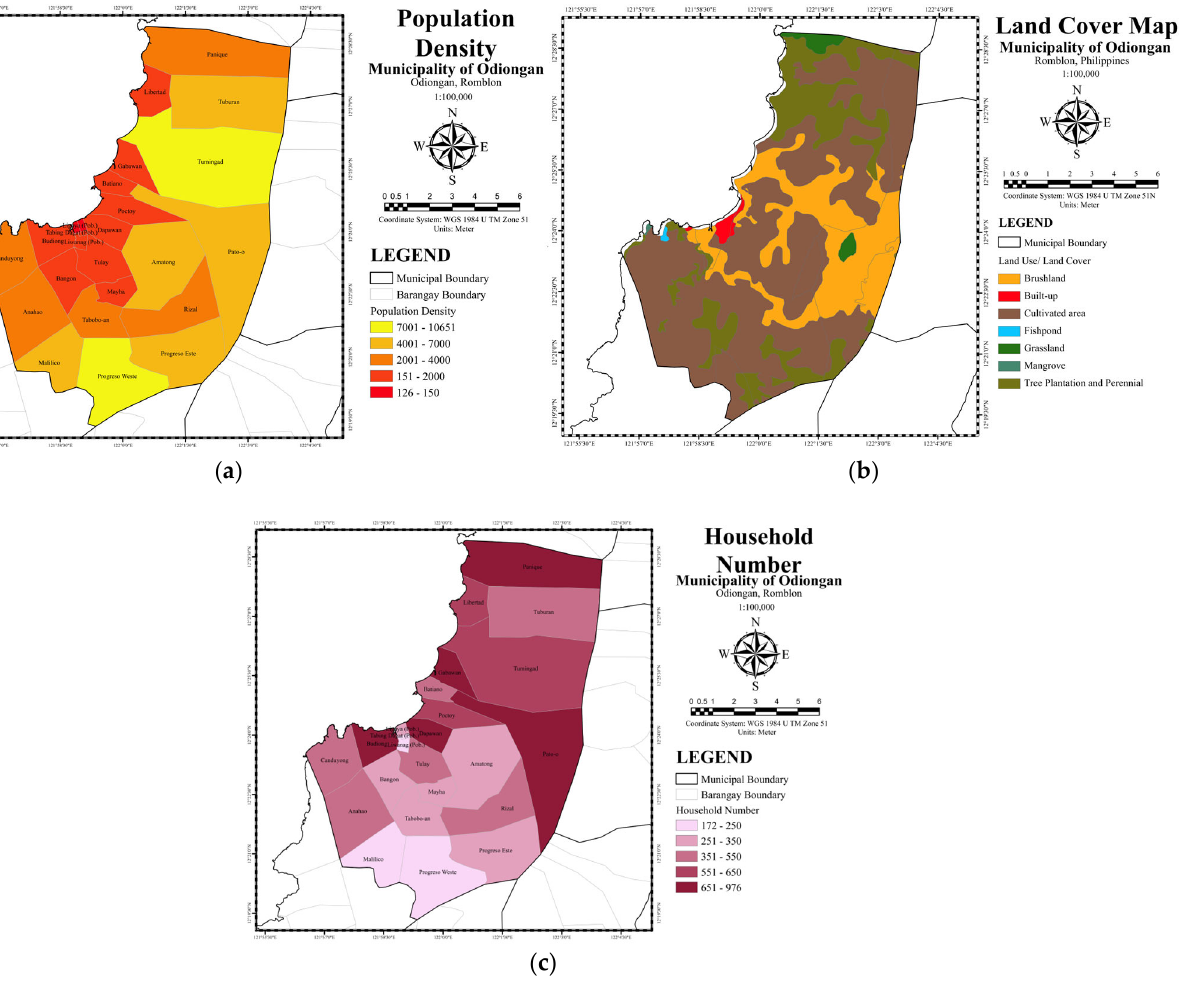
Figure 8. Result maps for flood exposure parameters in using ArcMap: ( a ) Population Density; ( b ) Land Use Map; and ( c ) Household Number.